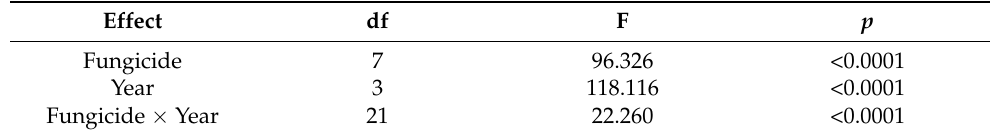
Table 1. Analysis of variance (ANOVA) for the effect of fungicide, year and their interaction on EC 50 values (mg/L) of Zymoseptoria tritici field populations summarized for all tested demethylation inhibitors (DMIs; tebuconazole, propiconazole, prothioconazole, mefentrifluconazole) and years of Z. tritici isolation (1999, 2009, 2014, 2020). In each year, Z. tritici field populations were isolated from wheat crops (cultivar “Ritmo”) at two locations in Northern Germany.